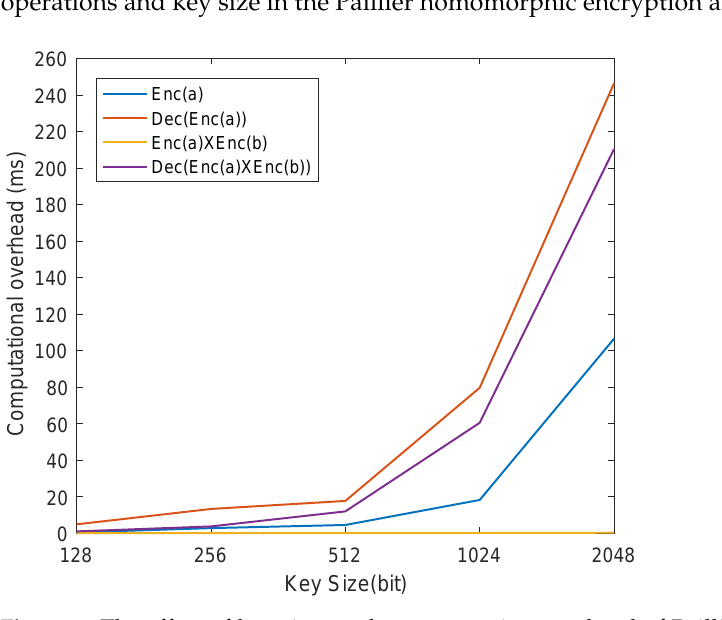
Figure 7. The effect of key size on the computation overhead of Paillier homomorphic encryp- tion algorithm.